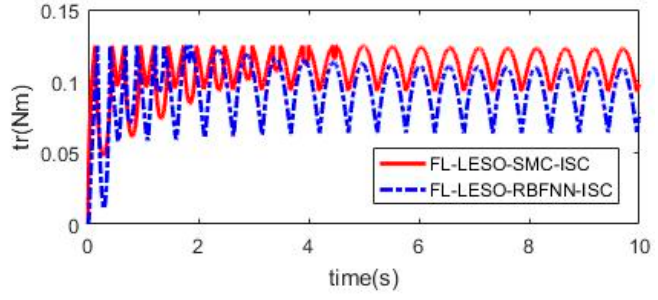
ff ness motor resistant Figure 15. the stiffness motor resistant torque. Figure 15. The sti